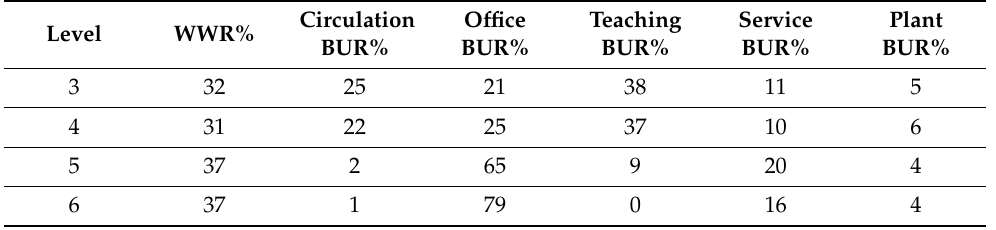
Table 5. Building characters for level 3 to